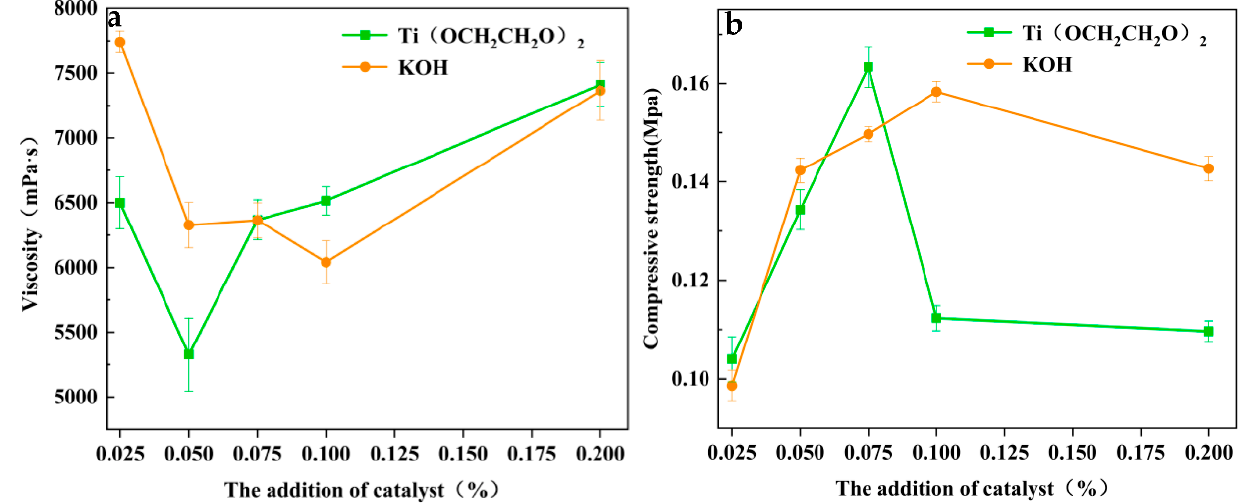
Figure 10. Effects of different catalytic systems on the viscosity of regenerated polyether polyol ( a ) and the compressive strength of regenerated PU ( b ).